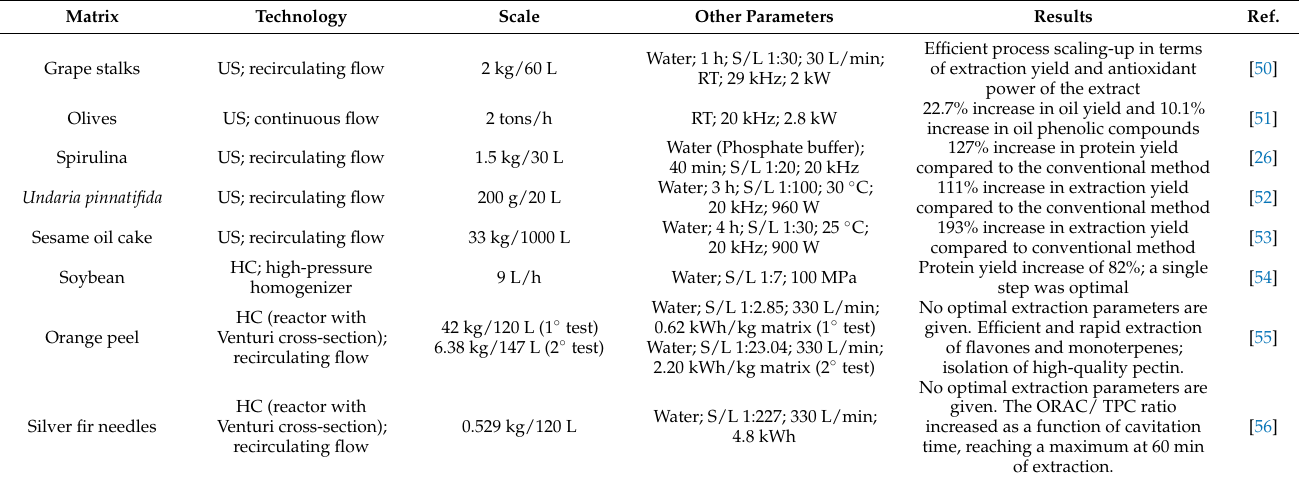
Table 1. Pilot and semi-industrial scale US extraction studies, from 2017 to 2022.